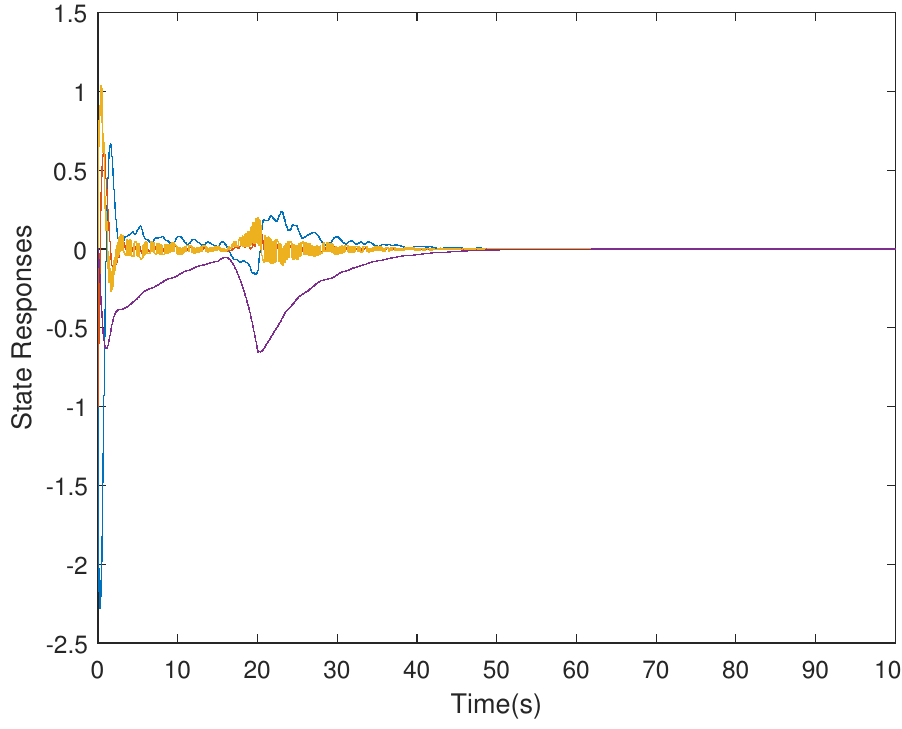
Figure 2. State responses of the LFC system in Case